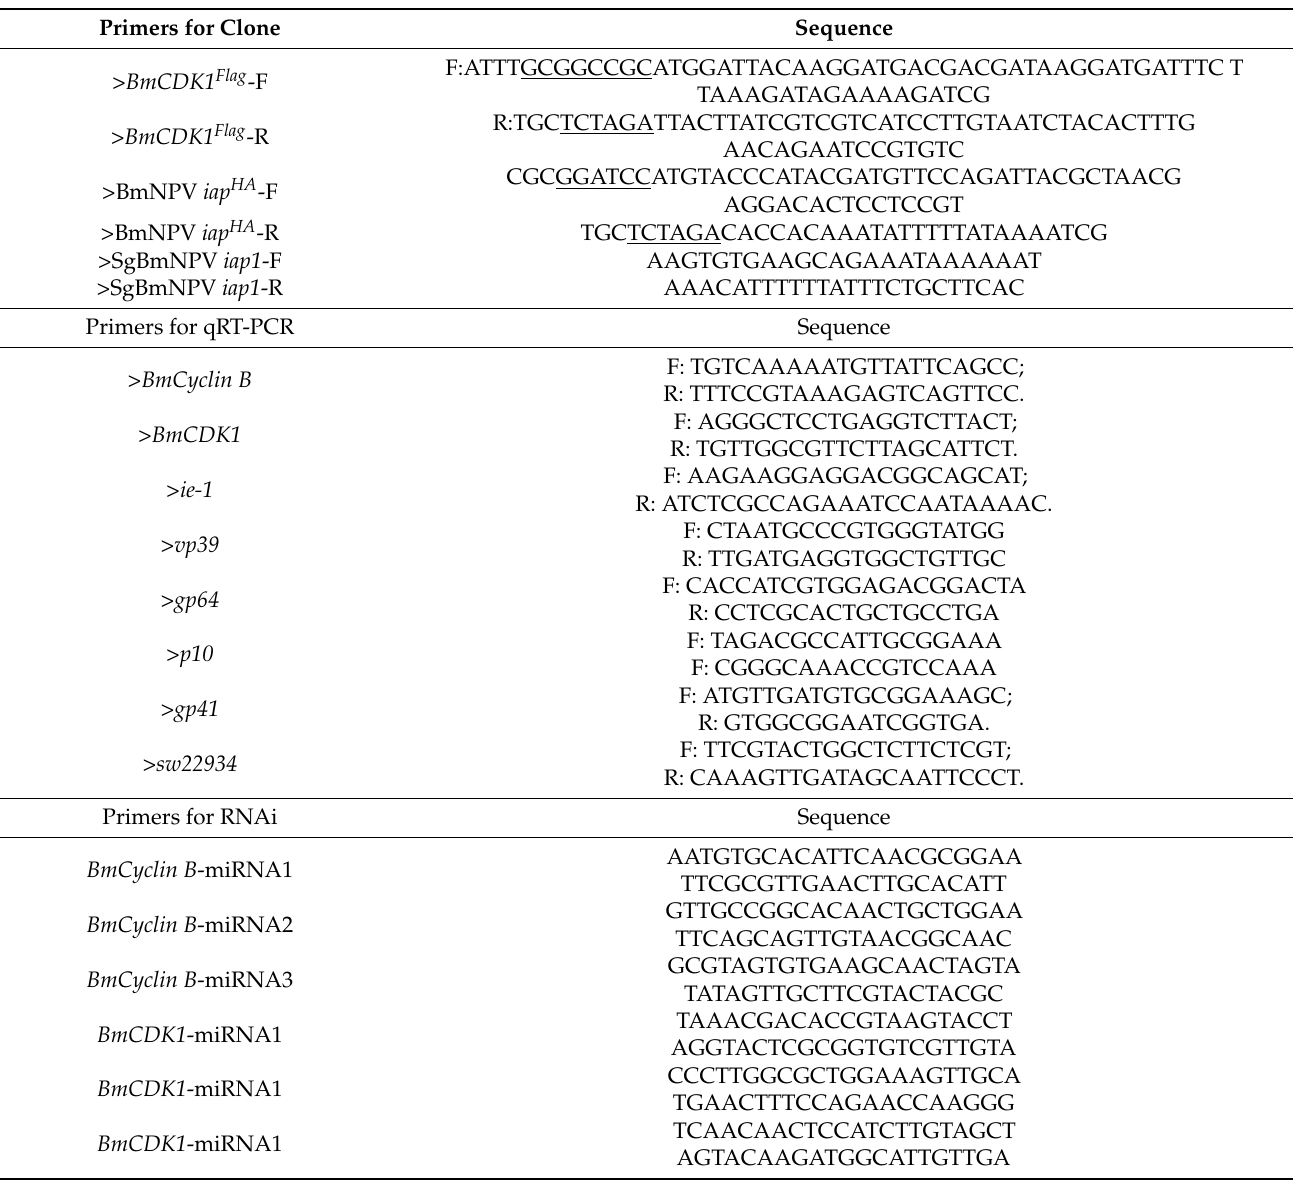
Table 1. Primers used in current